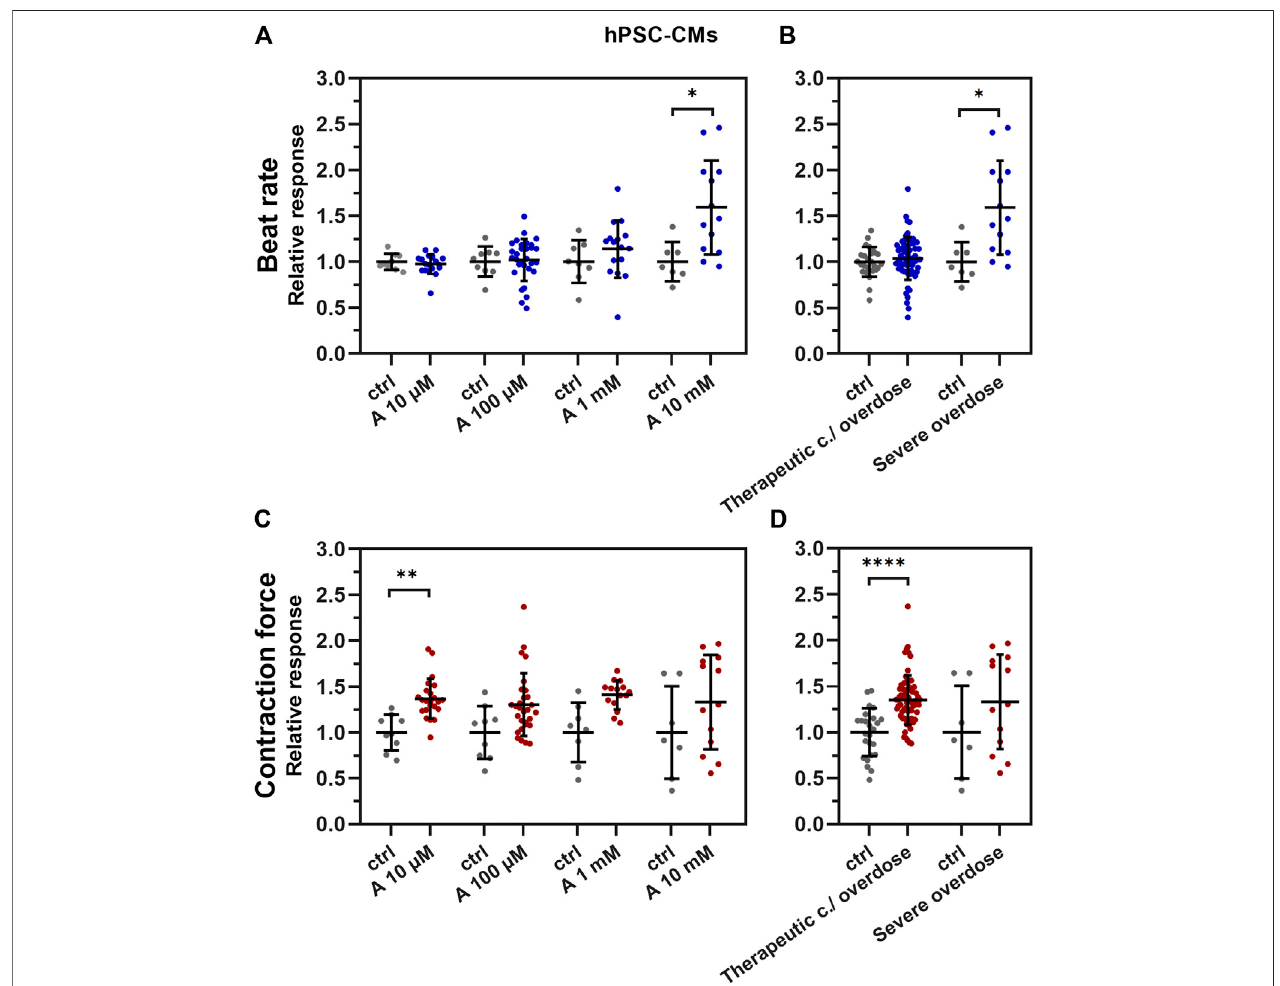
FIGURE 3 | Effect of aminophylline (A) on contractile properties of 3D cardiac clusters. Scatterplots (mean ± standard deviation) of the BR (blue) and contraction force (red) overall changes, normalized to a baseline measurement (relative response) and to control measurement means ( n (cid:2) 19 for A 10 µM, n (cid:2) 30 for A 100 µM, n (cid:2) 16 for A 1 mM, n (cid:2) 13 for A 10 mM, n (cid:2) 9 for BR ctrl and n (cid:2) 7 for contraction force ctrl). At least four biological repetitions were used in each column. (A) BR of the measuredEBswith10 mMaminophylline(A10 mM)wassigni fi cantlyincreasedcompared tothatofthecontrol( p < 0.05). (B) Similarly,theBRofEBstreatedwith 10 mM concentration of aminophylline was signi fi cantly increased over that of the controls ( p < 0.05). (C) Contraction force of EBs with 10 µM aminophylline treatment was signi fi cantly increased over that of the control ( p < 0.05), with a similar trend in higher concentrations. (D) Group analyses then showed a strong statistically signi fi canteffectoftherapeuticconcentration/overdose(10 μ Mand100 μ Mand1mM)aminophyllineoverthecontrols.(Brown – ForsytheandWelchANOVAtestswere used in all